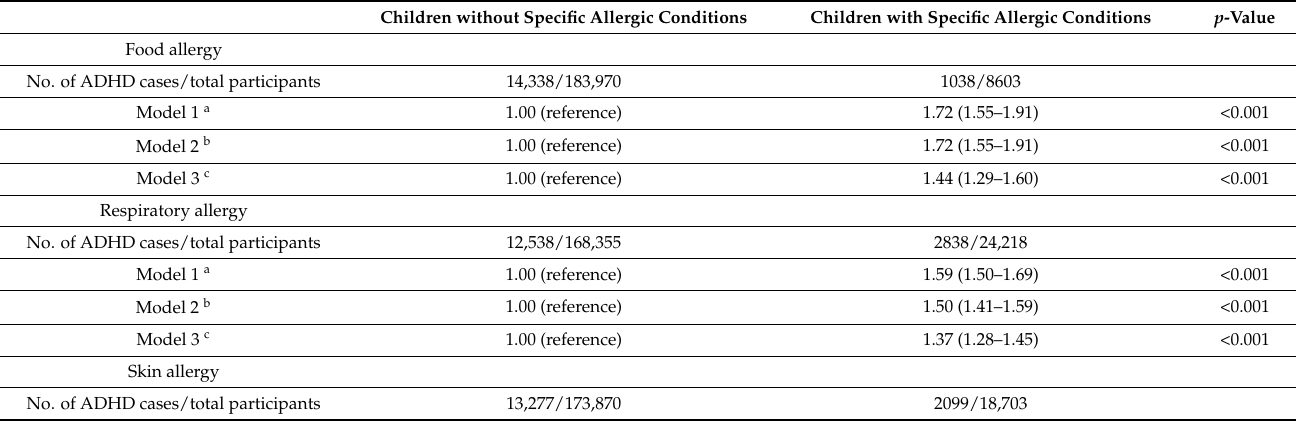
Table 4. Association of allergic conditions with ADHD ( n =